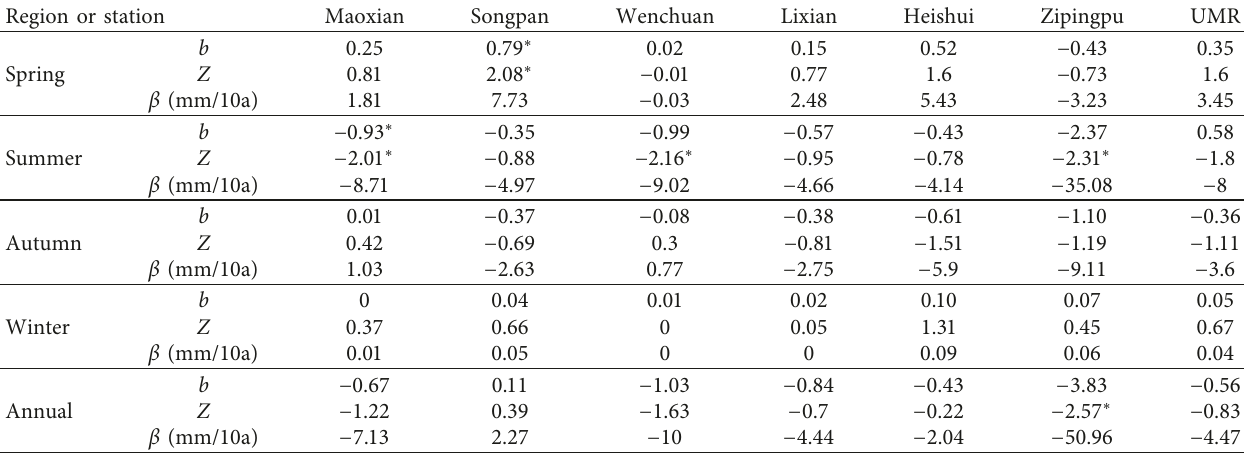
Table 3: Values of b in linear regression analysis and Z and β in MK of UMR. Region or